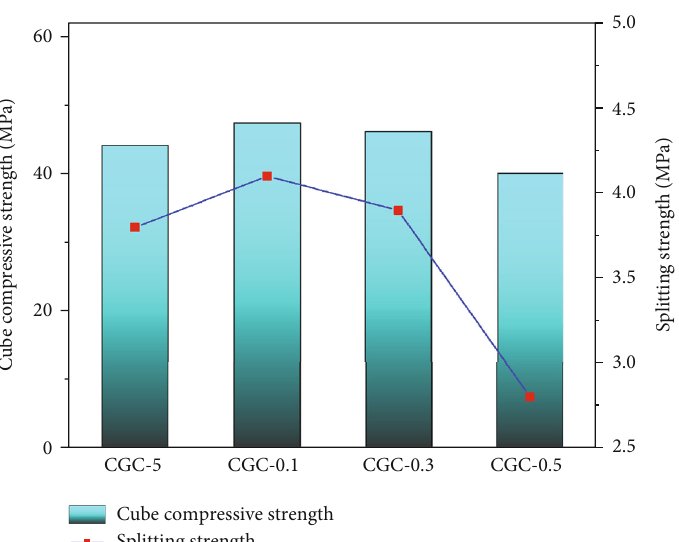
Figure 10: Cube compressive strength and splitting tensile strength of PET fi ber-reinforced coal gangue fi ne aggregate concrete.